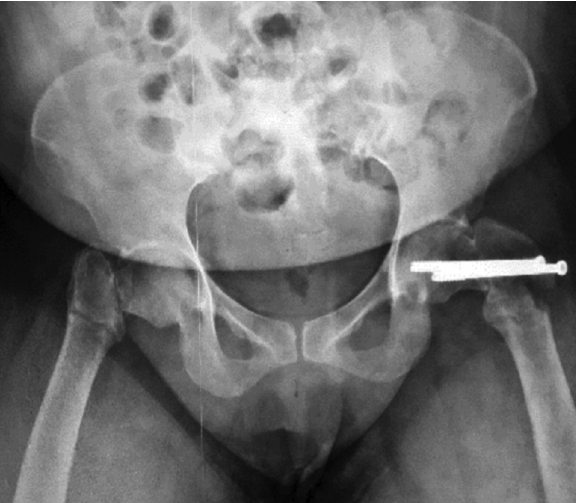
Pelvis AP radiograph at admission showing right sided Fig. 1: transcervical neck of femur fracture with left intertrochanteric fracture. Two screws intact in the left neck of femur from previous fixation.